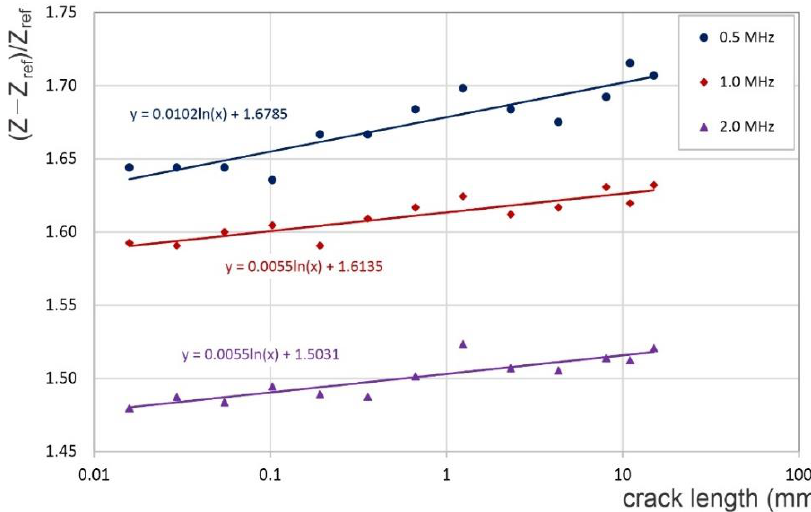
Figure 15. The experimental relative change in impedance with the crack length for three driving frequencies.